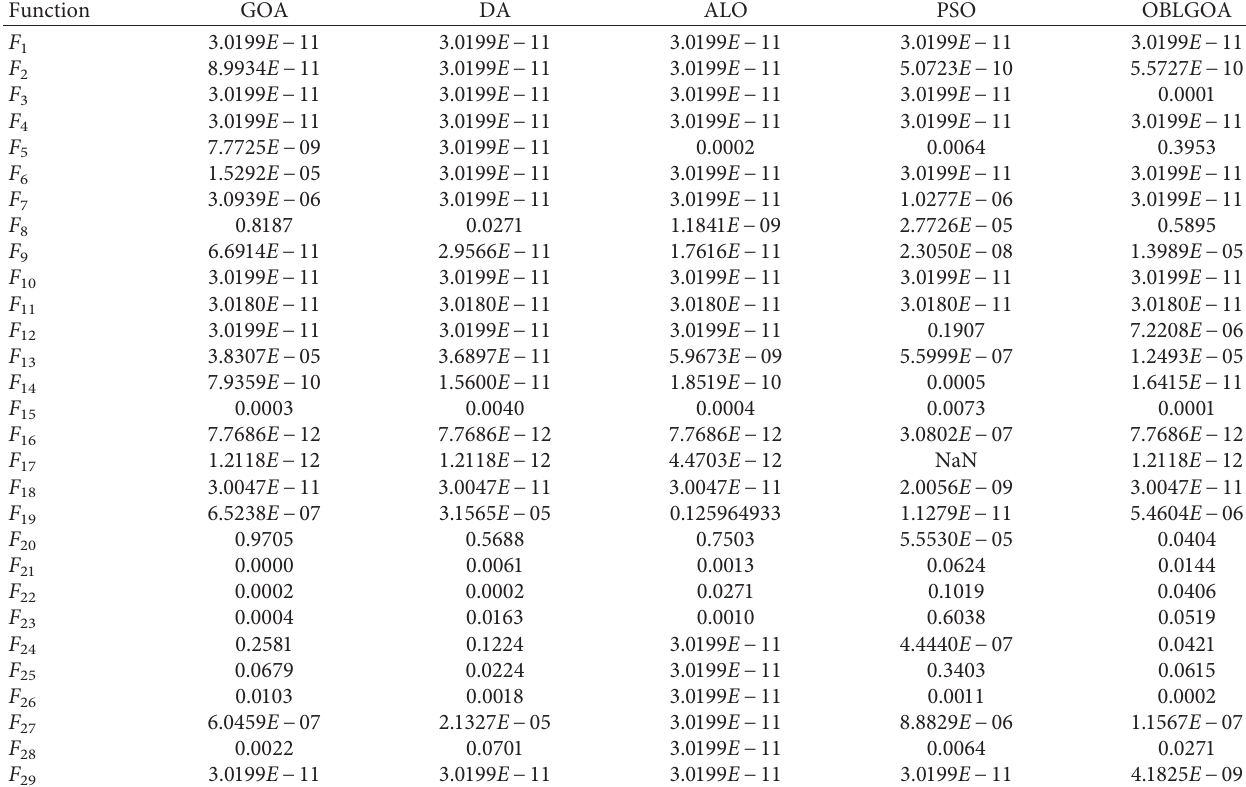
Table 4: The Wilcoxon rank sum test for multimodal functions.